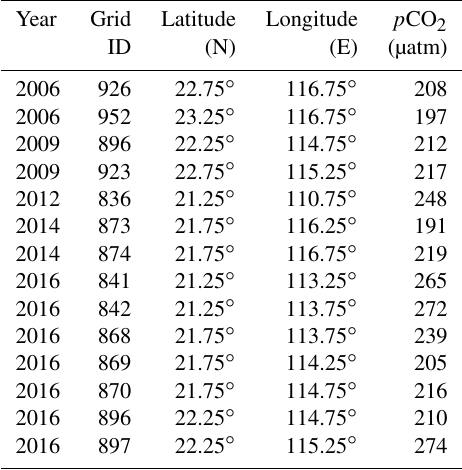
Table 3. Outliers excluded from the SOG